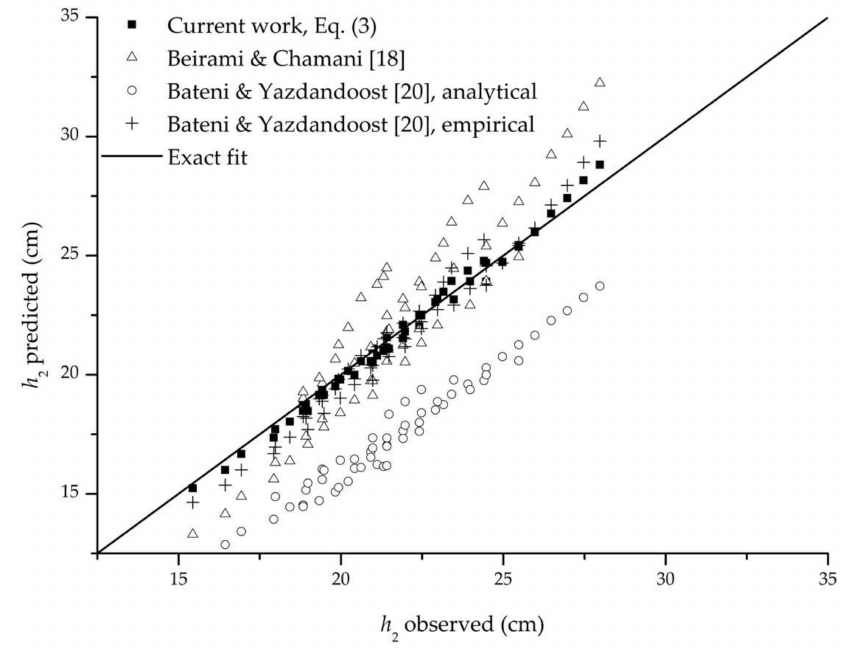
Figure 9. Comparison of different methods for predicting downstream depth h 2 for B-F